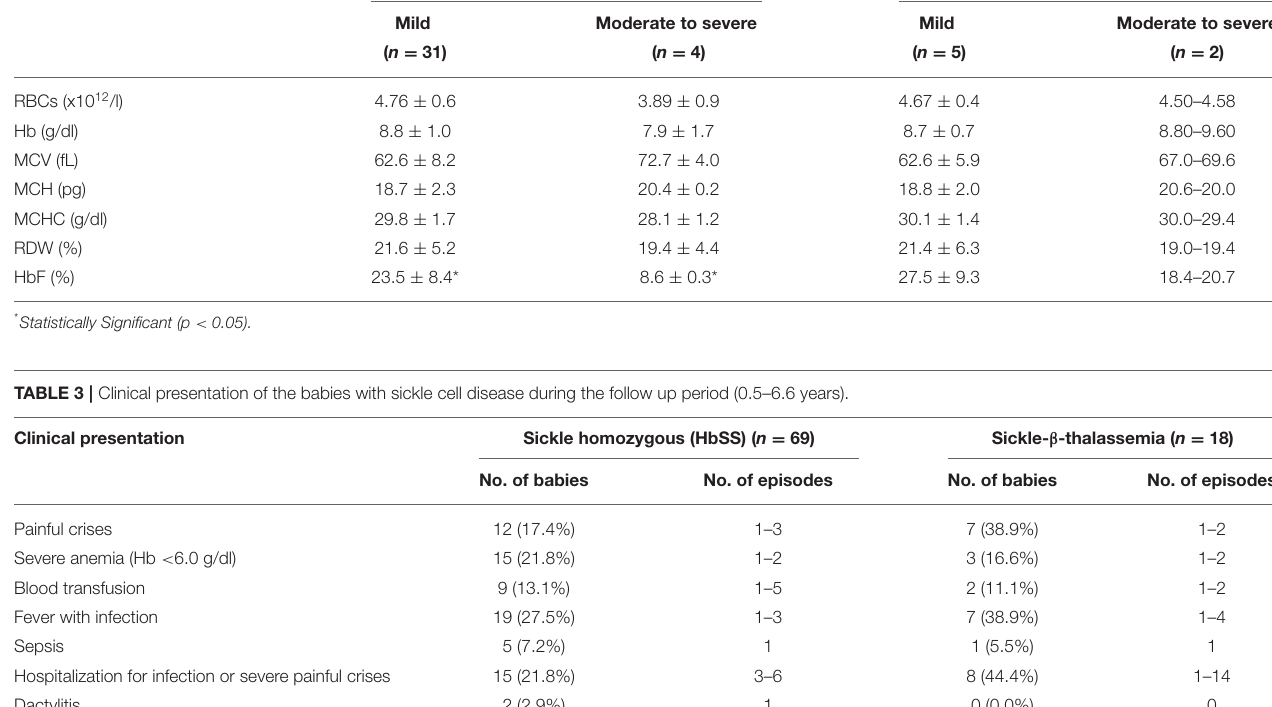
TABLE 2 | Hematological findings during follow-up of babies with HbSS and HbS- β -thalassemia having mild and moderate to severe clinical presentation. Hematological parameters